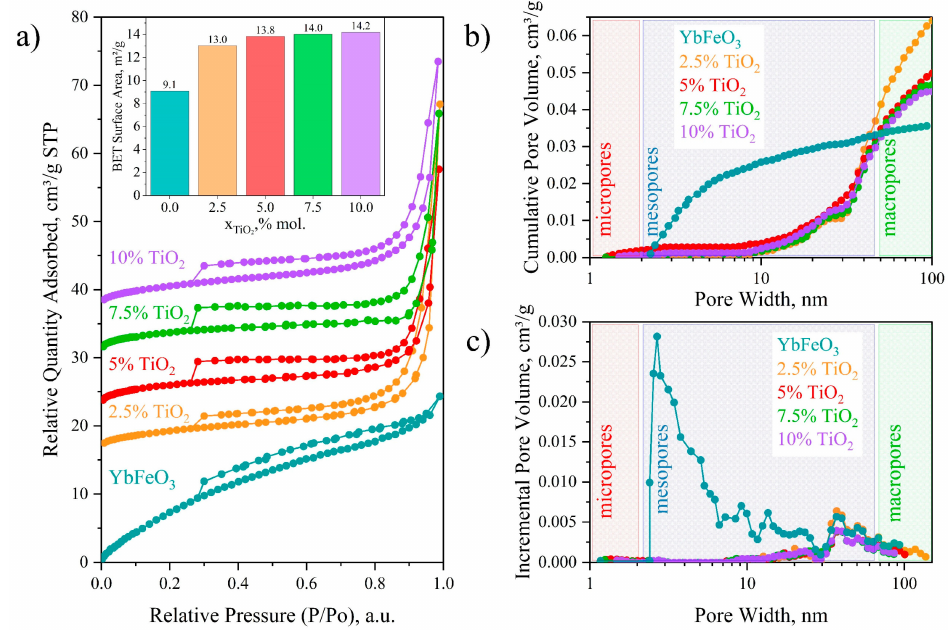
Figure 6. Low-temperature N 2 sorption–desorption isotherms ( a ), cumulative ( b ), and incremental ( c ) pore volume distribution of h -YbFeO 3 / o -YbFeO 3 /TiO 2